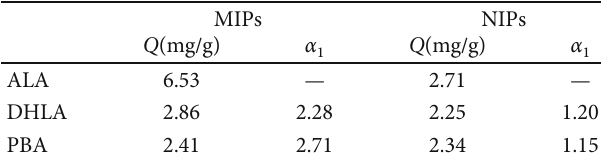
Figure 5: Adsorption capacities of MIPs and NIPs with di ff erent molar ratios. Table 5: The selectivity factor α of the MIPs and NIPs.